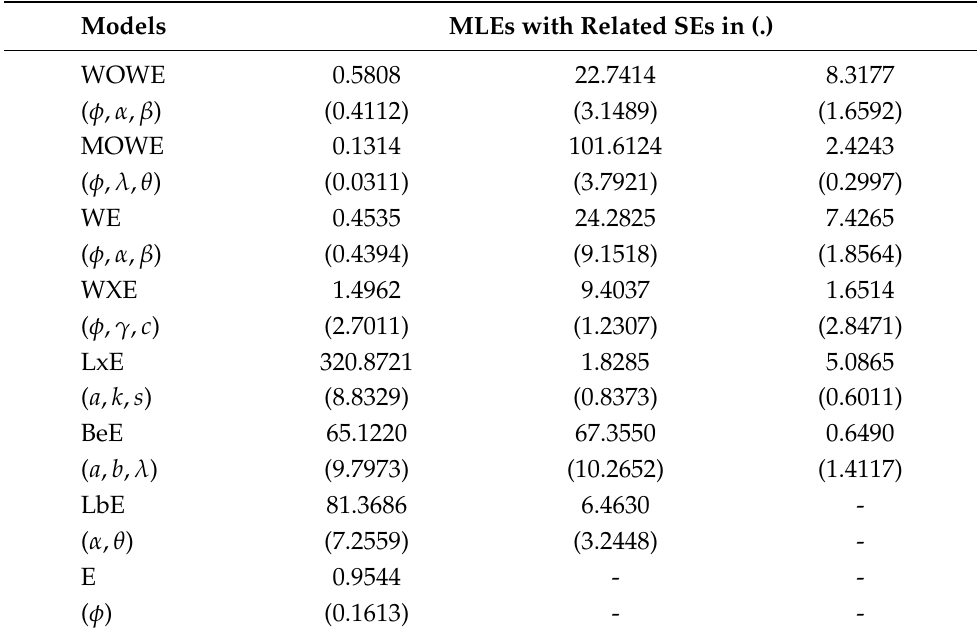
Table 7. MLEs and SEs of the parameters of the considered models for the daily precipitation data.